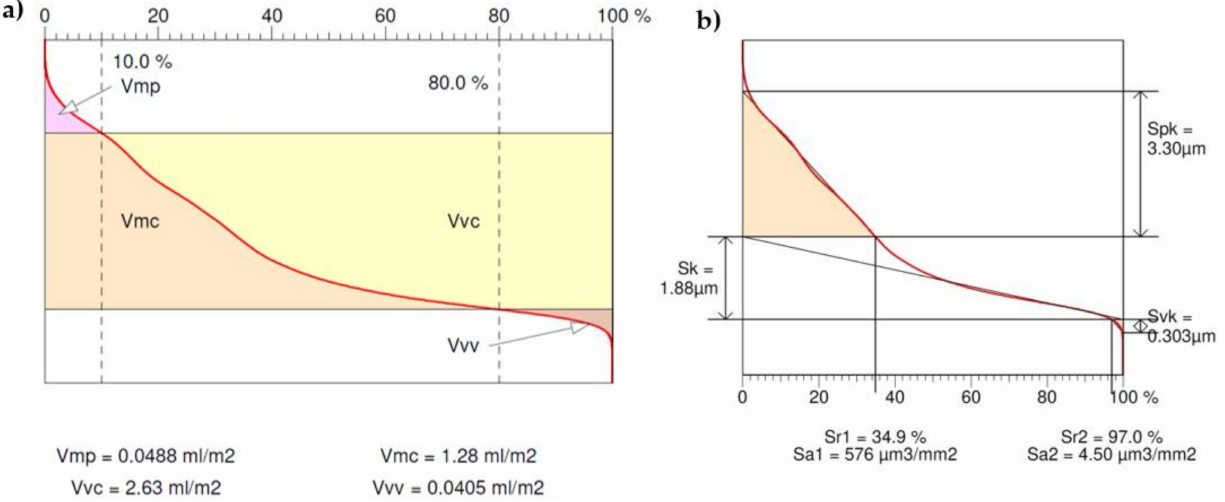
Figure 11. Abbott–Firestone curve (bearing area curve): ( a ) surface volumetric functional parameters; ( b ) position of the linearizing line of the curve (surface amplitude